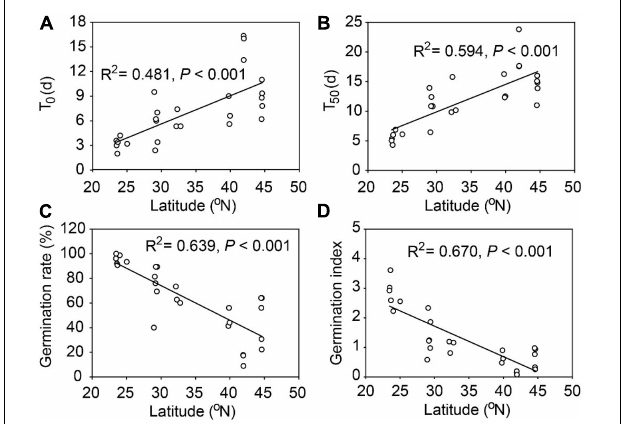
FIGURE 1 | Seed germination traits for 26 populations of Ambrosia artemisiifolia along 23 ◦ latitudinal range in China. (A) T 0 , number of days of the first germination from the beginning of germination test; (B) T 50 , number of days required to reach 50% of final germination rate; (C) seed germination rate; (D) germination index